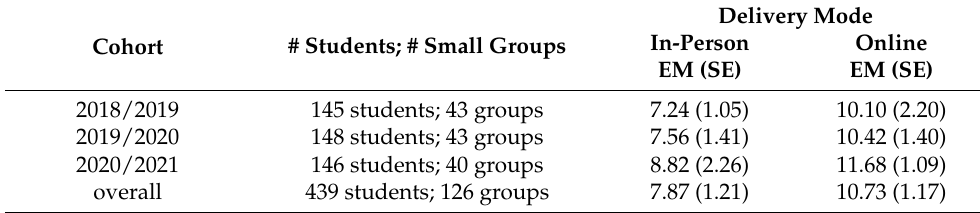
Table 1. Estimated mean differences (standard errors) between IRAT and GRAT scores based on deliv- ery mode (with cohort, delivery mode, and session order entered as predictors in the GEE analysis).